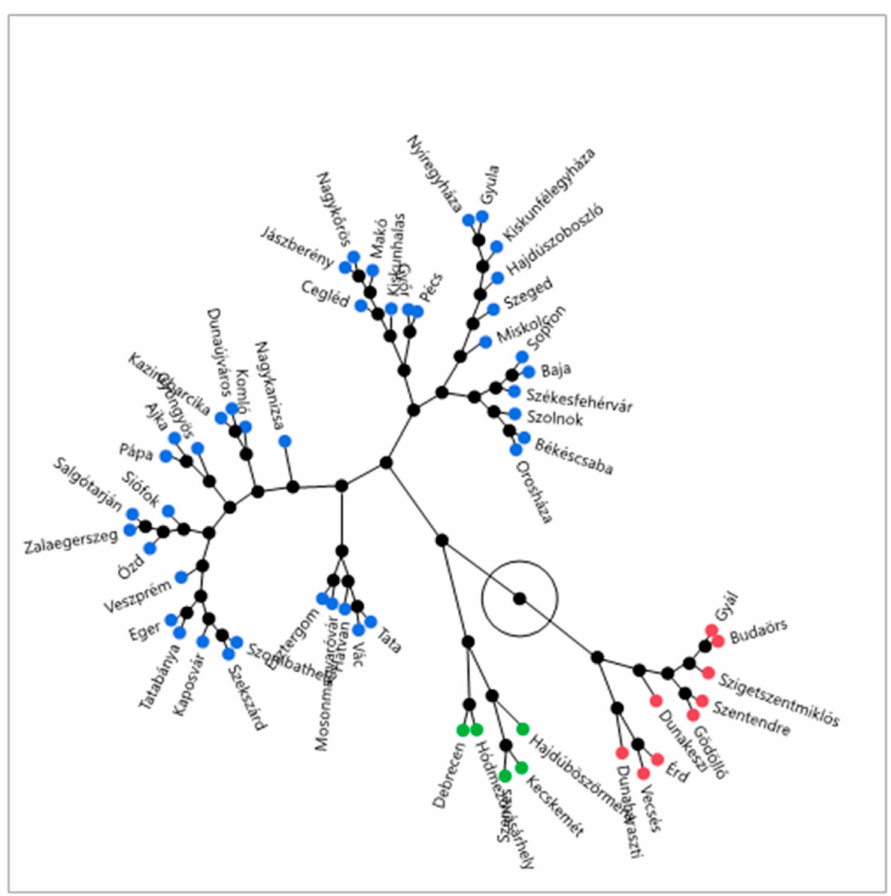
Figure 5. The groups created by the K-center clustering procedure ( n =